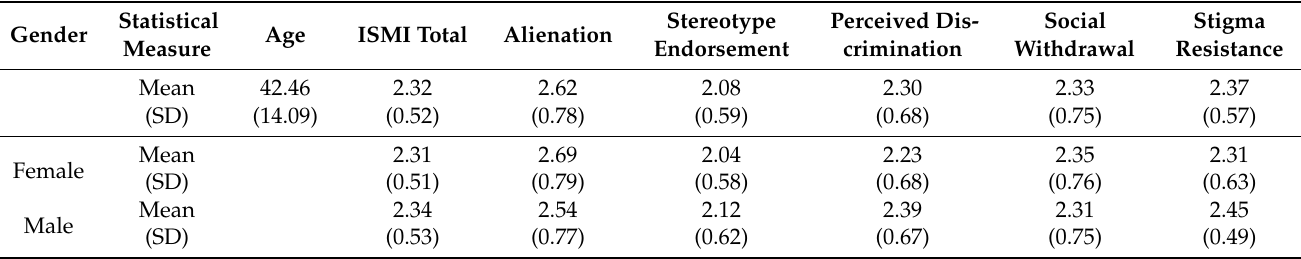
Table 2. Study sample characteristics (2).